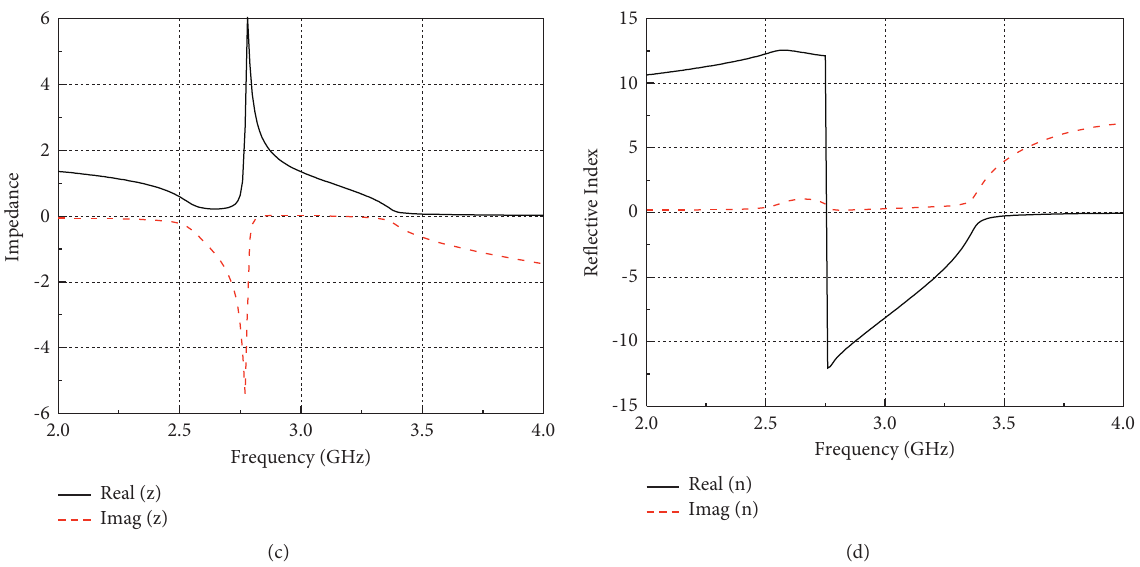
Figure 3: Retrieved effective parameters using ‘S Parameters Retrieval Method:’ (a) effective permittivity, (b) effective permeability, (c) normalized impedance, and (d) refractive index.